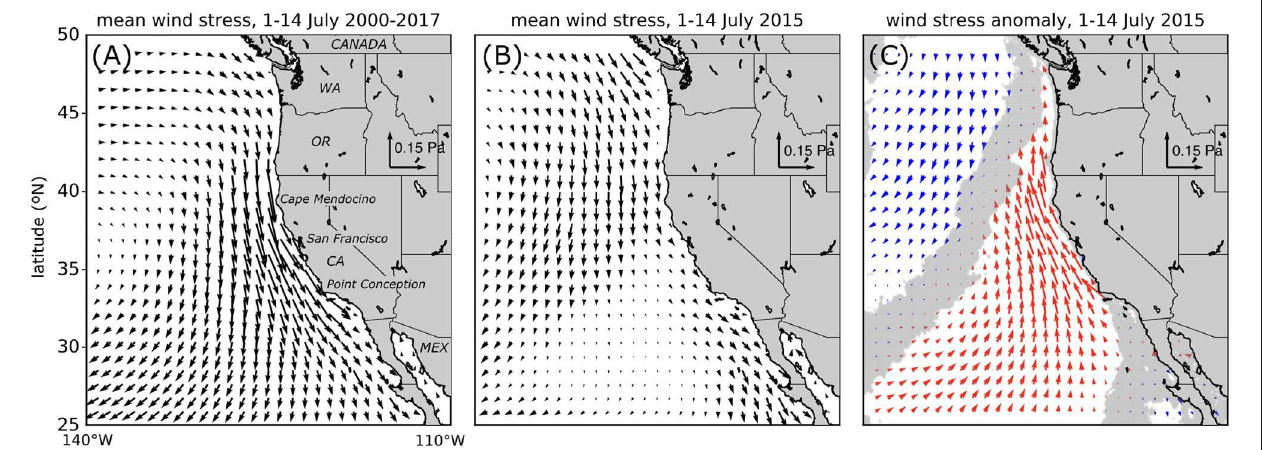
FIGURE 2 | 1–14 July wind stress climatological mean, 2015 mean, and anomaly preceding the development of the split MHW. (A) Mean wind stress during 1–14 July 2000–2017. Arrows indicate the wind stress direction in oceanographic convention, i.e., the direction the wind is blowing toward. (B) Mean wind stress during 1–14 July 2015. (C) Time-mean wind stress anomaly, relative to the long-term mean in (A) , during 1–14 July 2015. (C) is equal to (B) minus (A) . In (C) , vectors are colored red if the northward component of the wind stress vector anomaly is positive, which along the coast corresponds to wind relaxation, and blue if the northward component of the wind stress anomaly is negative. Gray shading in (C) indicates anomaly is not significantly different from zero at the 95% confidence level (section